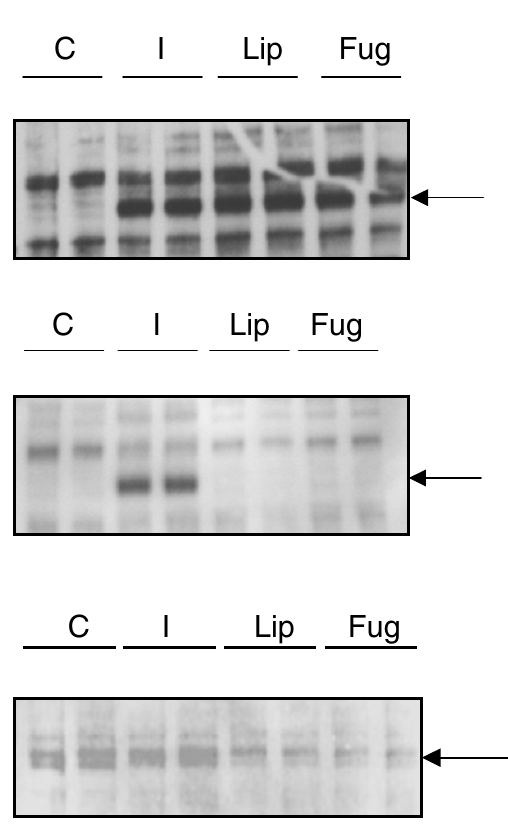
coincides with the insulin receptor beta chain) is indicated by the arrow. Middle panel: Cho.hIR cells were treated as above except that treatment with LF2000 and FuGENE lasted 24 hours and blotted for phosphotyrosine. Lysates labelled "I" are from cells incubated for 24 hours as control cells and subsequently stimulated with insulin for 10 minutes to con- firm that cells are otherwise responsive to insulin after the incubation period. The position of the 97kDa marker is indi- cated by the arrow. Lower panel: The same cells as in the middle panel were blotted for the presence of the insulin receptor, which co-migrates with the 97kDa marker, indi- cated by the arrow. The blots are from a representative experiment repeated three